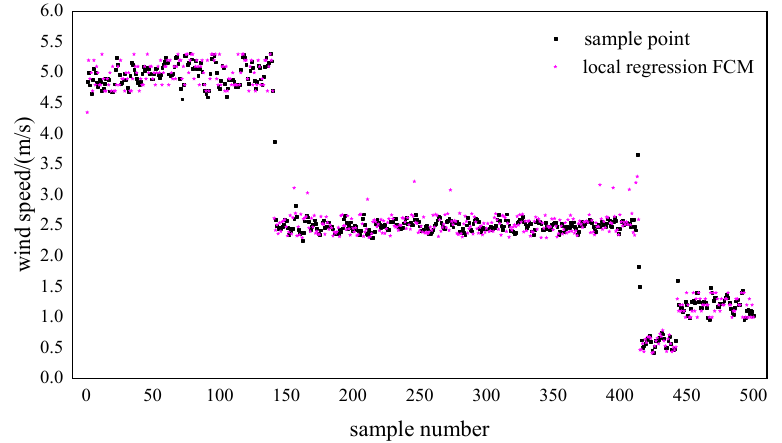
Figure 7. Comparison of the sample clustering plots of the two methods.